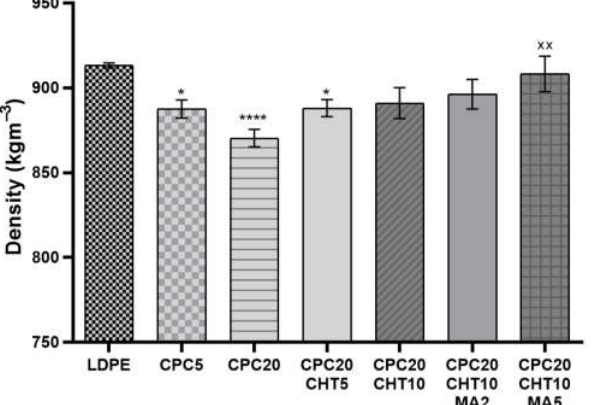
Figure 1. The density of the pristine low-density polyethylene (LDPE) and its cork biocomposites (CPC) containing chitosan (CHT) with or without maleic anhydride (MA). The significance levels between groups were 1 symbol— p < 0.05, 2 symbols— p < 0.01, and 4 symbols— p < 0.0001 related to: * LDPE; x CPC20.